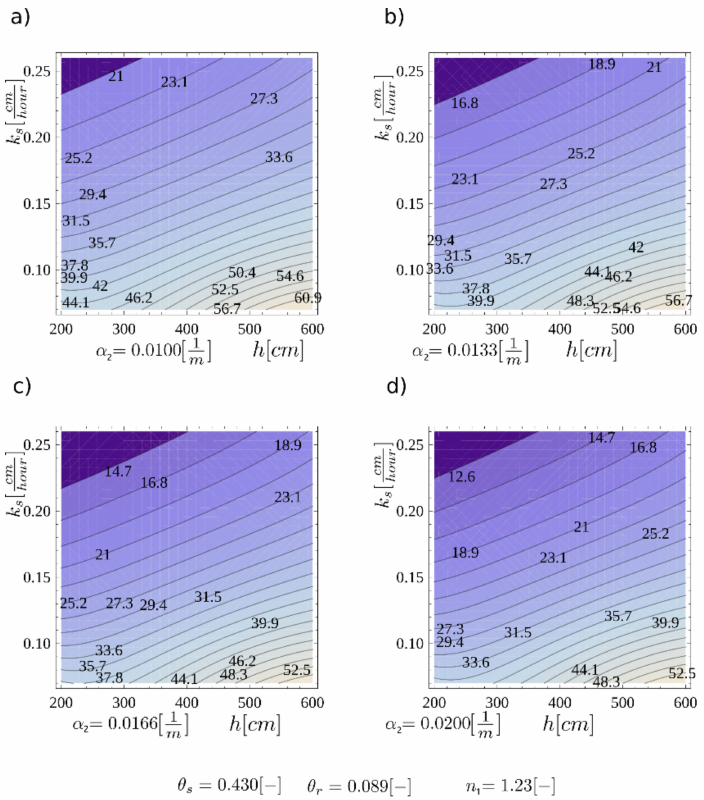
Figure 13. The differences (as in Equations (15) and (21)) in time to reach the limit t cft state for the four load factor RCSR values: ( a ) RCSR = 1.0000; ( b ) RCSR = 1.0050; ( c ) RCSR = 1.0100; ( d ) RCSR = 1.0150 (time is in 24 h).